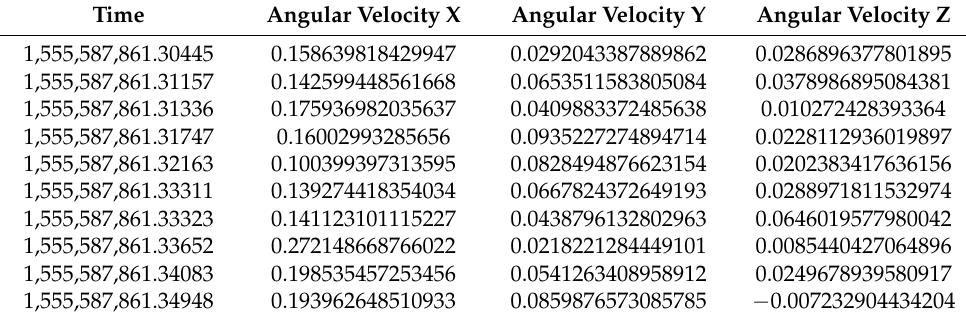
Table 1. Data samples of d1.